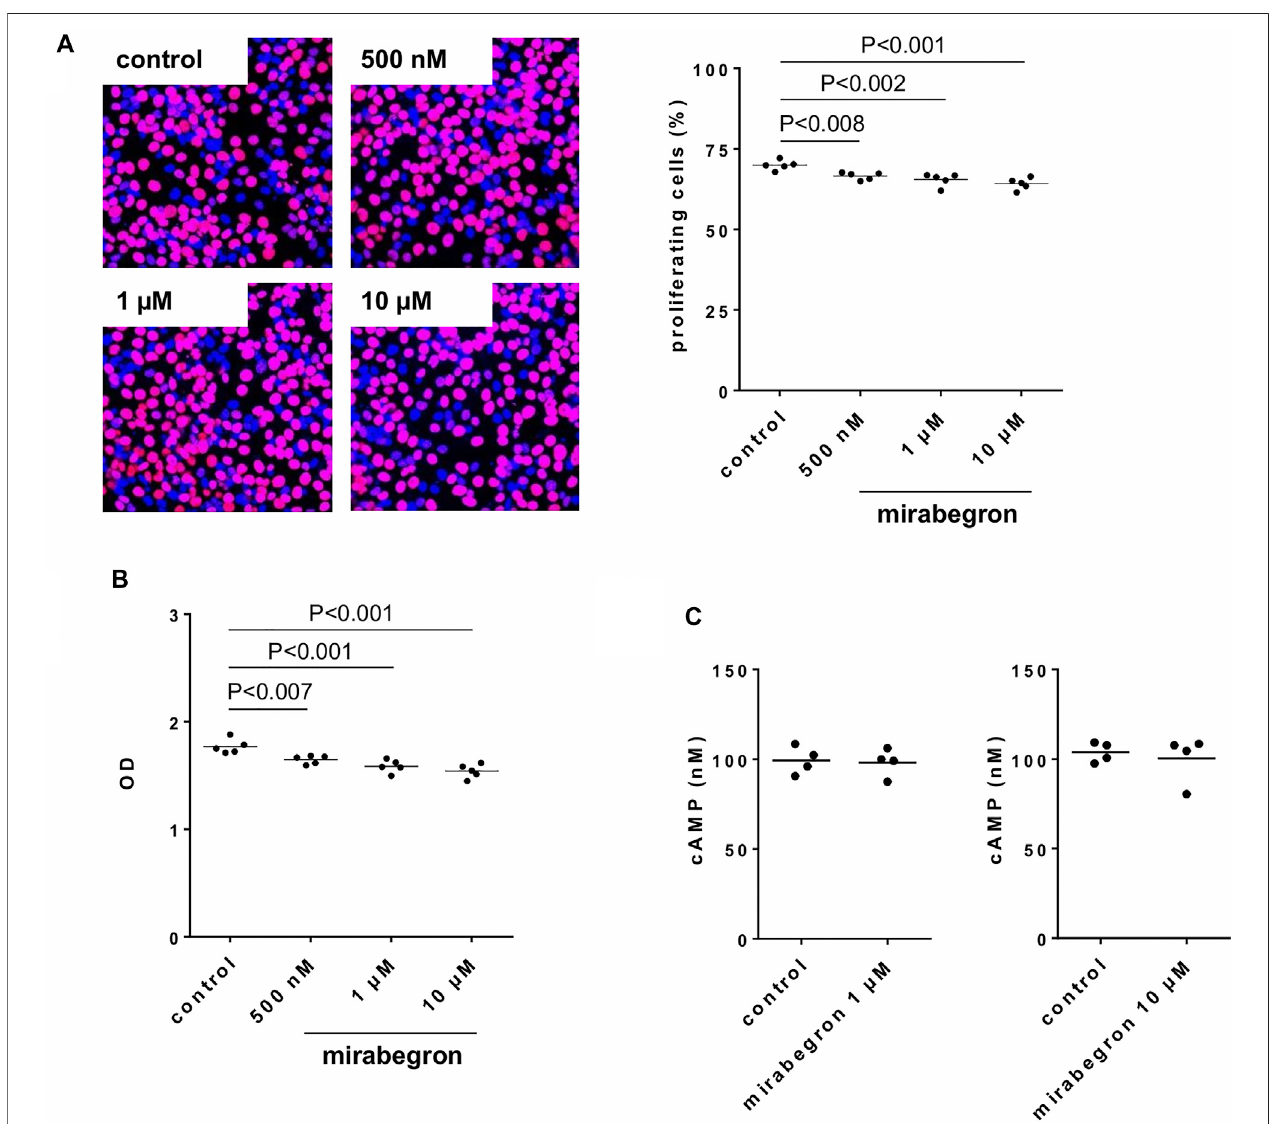
FIGURE 8 | Effects of mirabegron on proliferation, viability and cAMP formation in human prostate stromal cells. In (A) , proliferation was assessed by EdU assays (red, proliferating cells; blue, non-proliferating cells), following incubation of WPMY-1 cells with DMSO (controls) or mirabegron in indicated concentrations for 24 h. Proliferation is expressed as percentage of cells showing proliferation, referred to the number of all cells in a microscopic fi eld. In (B) , viability was assessed by CCK-8 assays, following incubation of WPMY-1 cells with DMSO (controls) or mirabegron in indicated concentrations for 48 h. Viability is expressed as extinction (OD), whichisthe fi nalreadout ofCCK-8 assays. In (C) ,cAMPin lysates wasassessed byELISAfollowing incubation ofculturedstromalcells with1 µM or10 µM mirabegron for 30 min, and in corresponding controls. In (A) and (B) , all single values together with means and p values (Dunnett ’ s test) from fi ve independent experiments for each setting are shown, together with pictures from represenative experiments from EdU assay. In (C) , all single values with means from four independent experiments are shown.